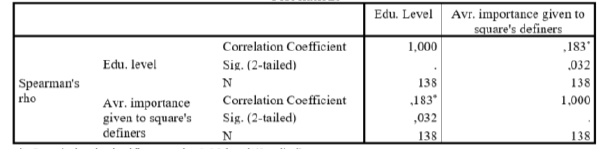
Table 2. Spearman’s Correlation between the educational level and the average importance given to the definers of Hergelen Square among the participants.